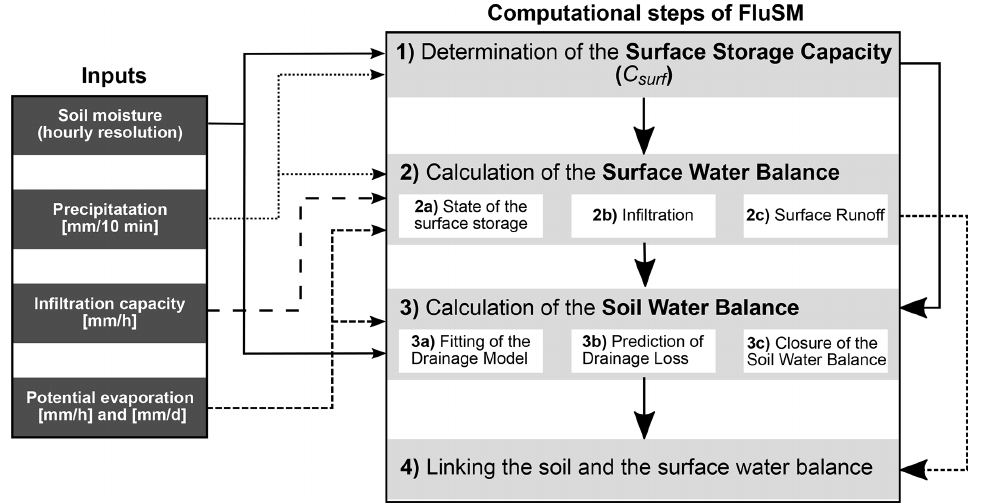
Figure 2. Inputs and computational steps of